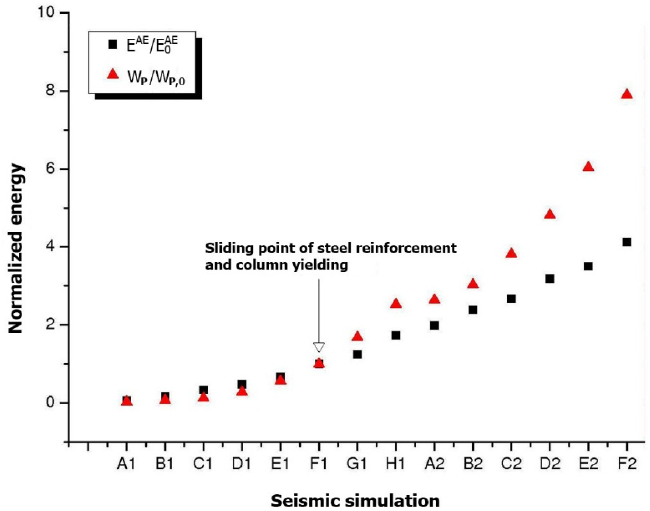
Figure 18 . Accumulated AE energy (black square) and accumulated plastic strain energy (red triangle). RC slab.